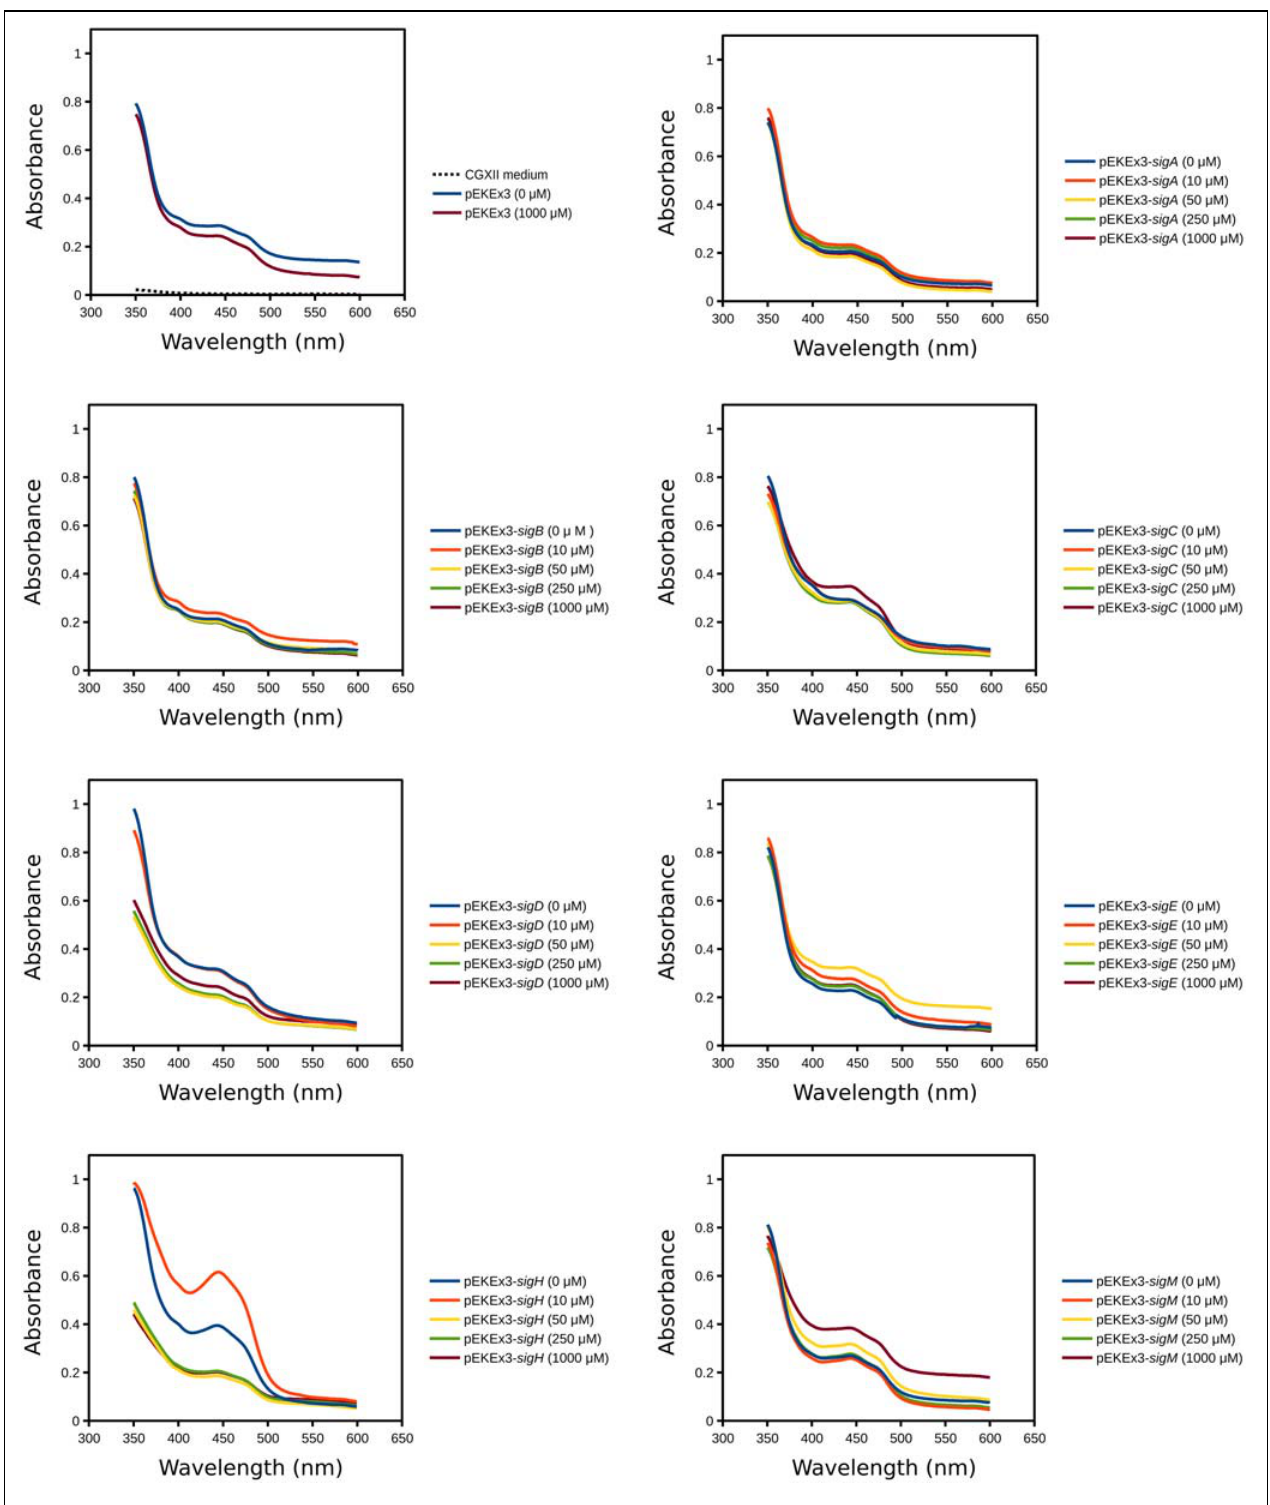
FIGURE 2 | Absorption spectra of supernatants of cultures of C. glutamicum WT transformed with plasmids for overexpression of various sigma factor genes. CGXII with 222 mM of glucose was used as growth medium. The IPTG concentrations and the plasmids used for overexpression of sigma factor genes are indicated. Supernatants were analysed after 48 h of